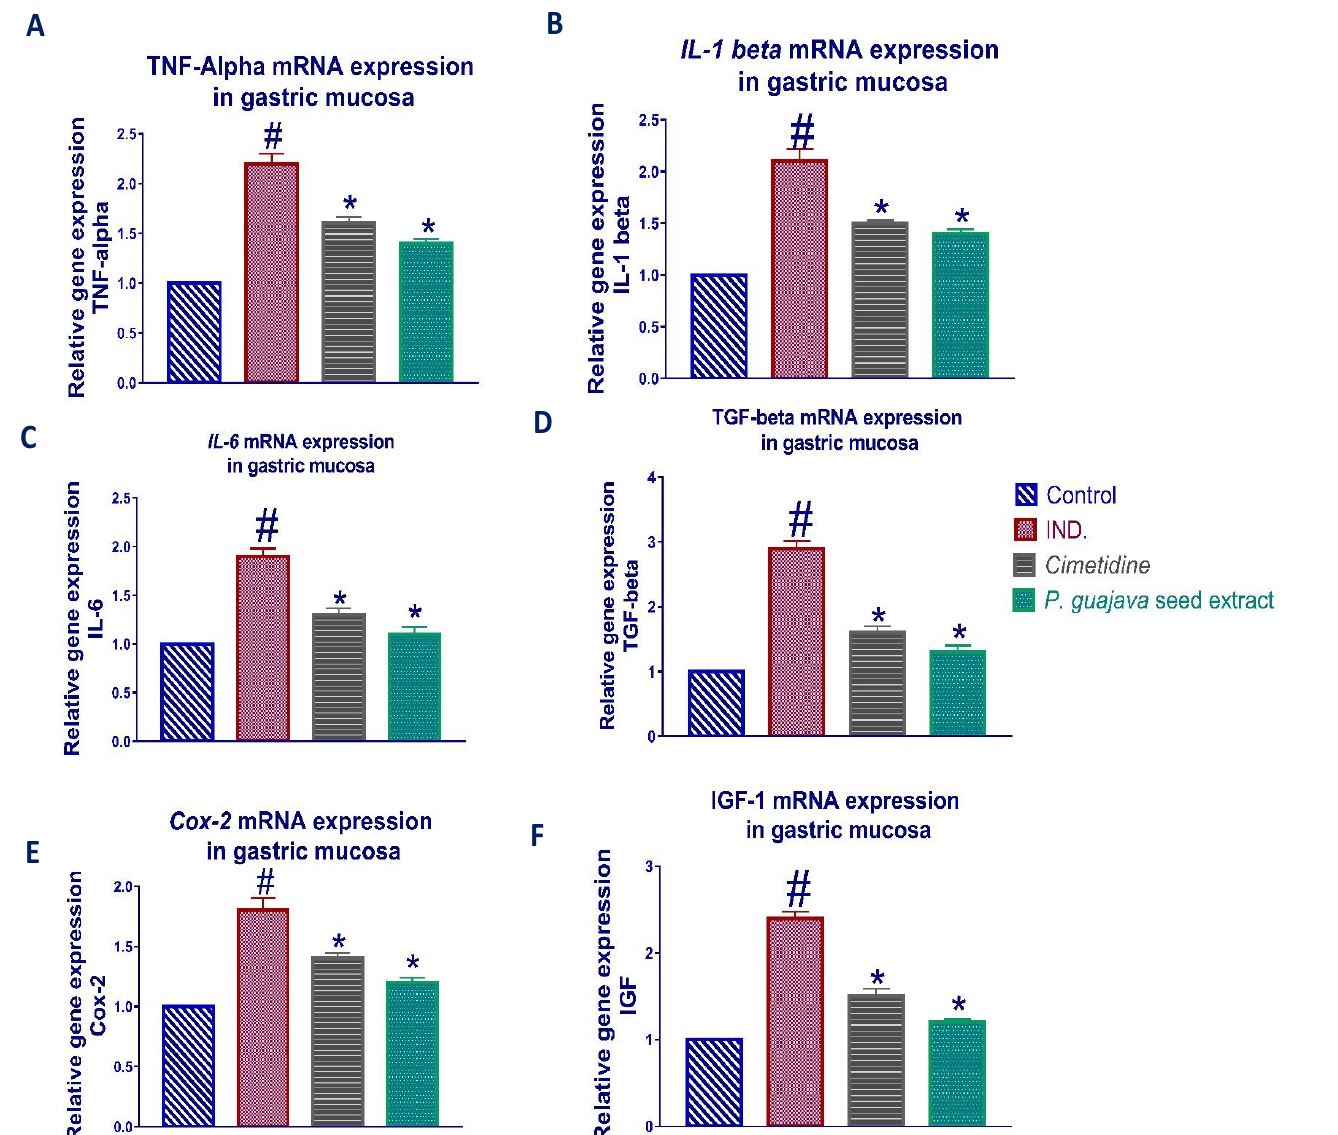
Figure 5. TNF- α ( A ), IL-1 β ( B ), IL-6 ( C ), TGF- β ( D ), COX-2 ( E ), and IGF-1 ( F ) relative gene expression in gastric mucosa tissue of different groups of rats was assessed using quantitative RT-PCR. After normalization to GAPDH , the data reflect a fold difference in expression compared to the normal control group. The bars show the mean ± standard deviation. To see if there is a significant difference between groups, a one-way ANOVA test is performed, with # p < 0.05 compared to the normal control group and * p < 0.05 compared to the indomethacin induced group.